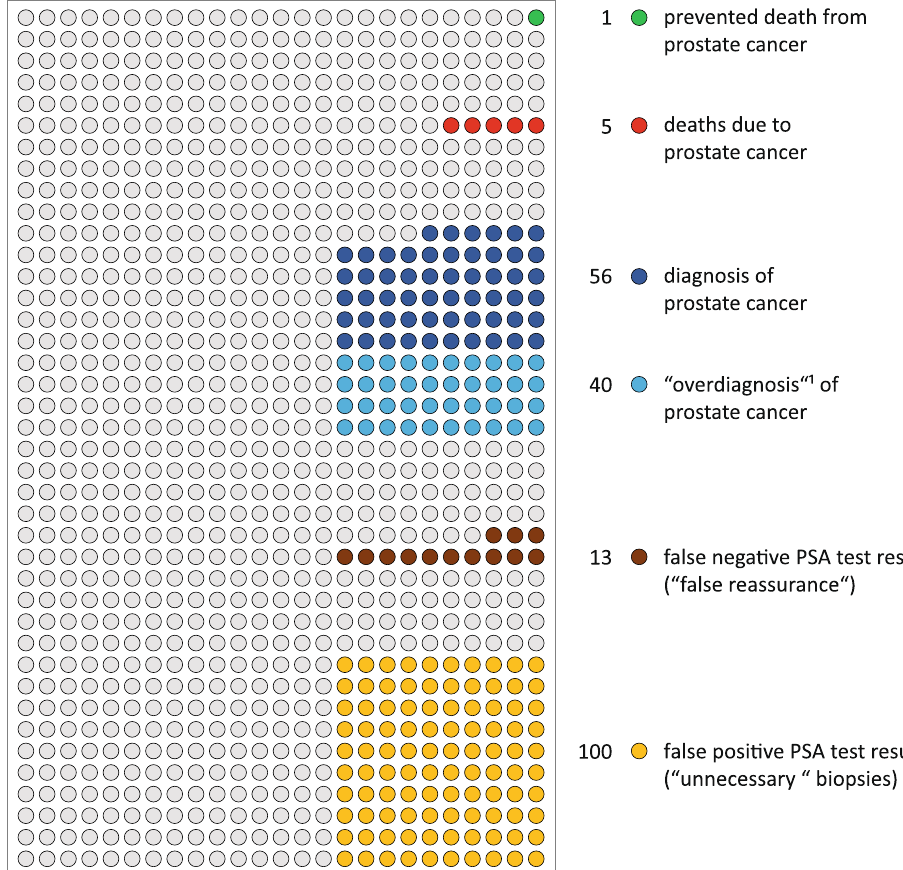
Figure 1. Pictogram of the “arriba-PSA”. It combines information from eight other pictograms included in the transactional DA based on 1000 men (1 circle = 1 man) in the age range of 55–69 years undergoing PSA based early detection of PCa during a period of ten years. It contains information about: dying of PCa within the next ten years; being diagnosed with PCa (risk of a clinically significant vs. not significant cancer) within the next ten years; having false-positive or false-negative PSA test results (risk of “unnecessary” prostate biopsies vs. “false reassurance”) referring to a period of four years only. 1 Overdiagnosis 16,17 : diagnosis of PCa unlikely to harm the man during his life-time. PSA = prostate specific